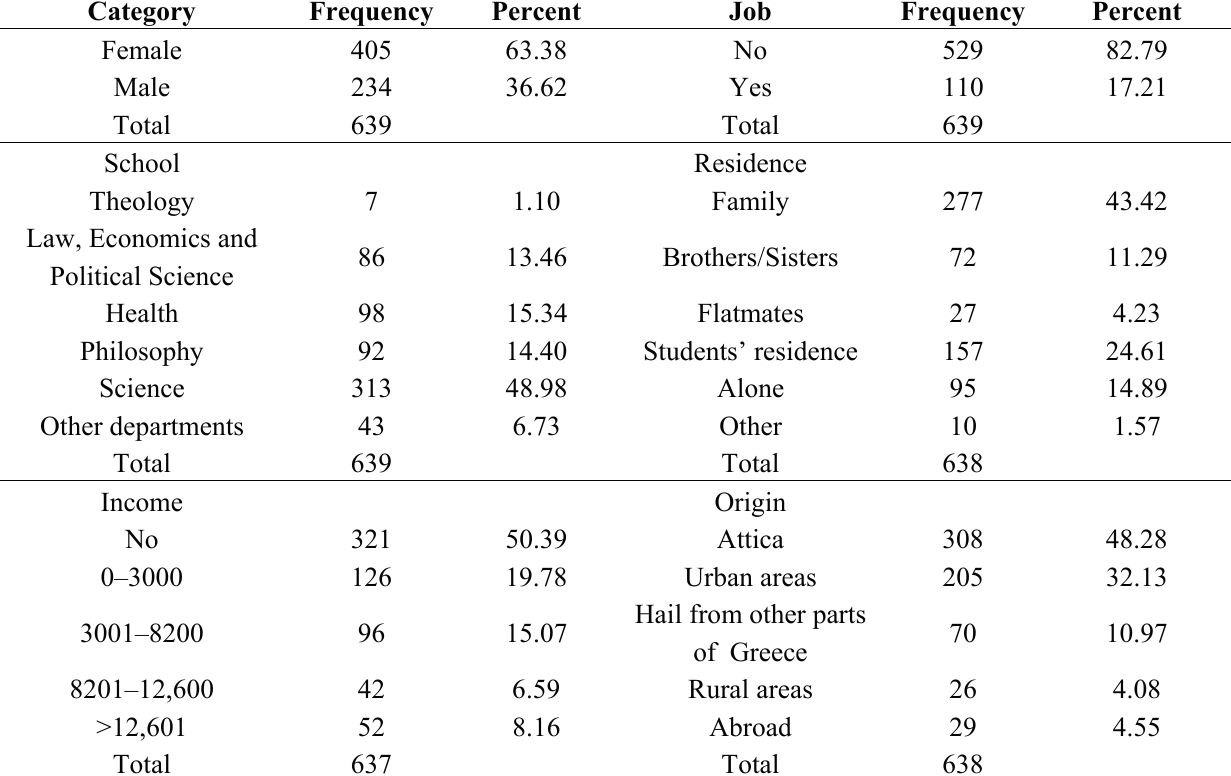
Table 1. Demographic characteristics of the